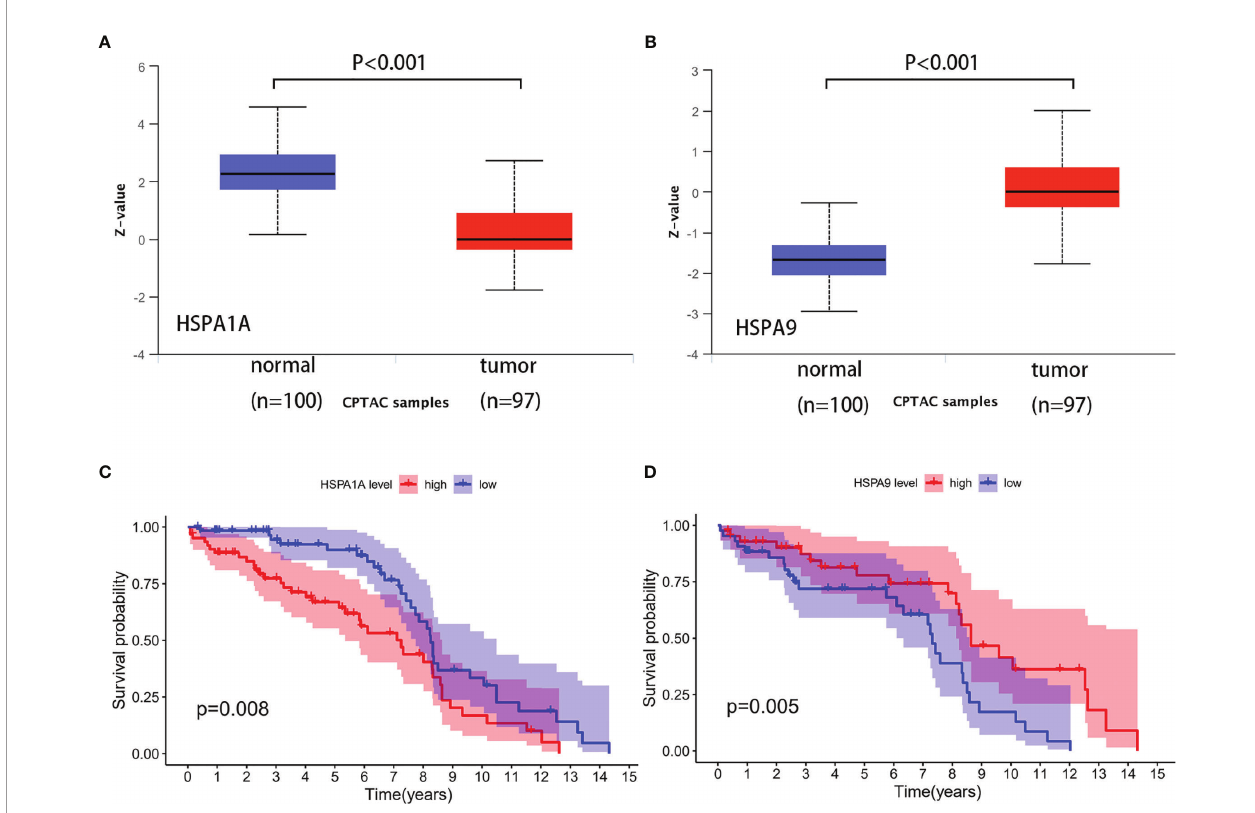
FIGURE 4 | Veri fi cation of HSPA1A and HSPA9 protein expression and the correlation to survival in colon cancer. (A) HSPA1A protein expression. (B) HSPA9 protein expression. (C) Survival of patients with high and low HSPA1A expression (sample from GSE28122). (D) Survival of patients with high and low HSPA9 expression (sample from